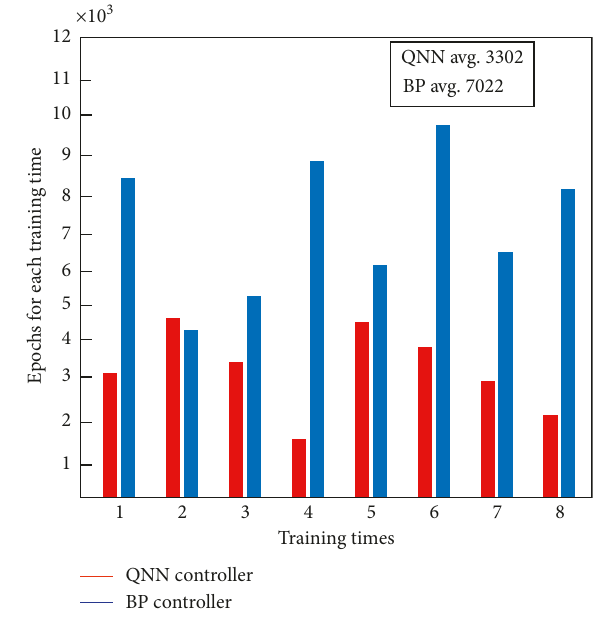
Figure 6: The epochs of eight training times.